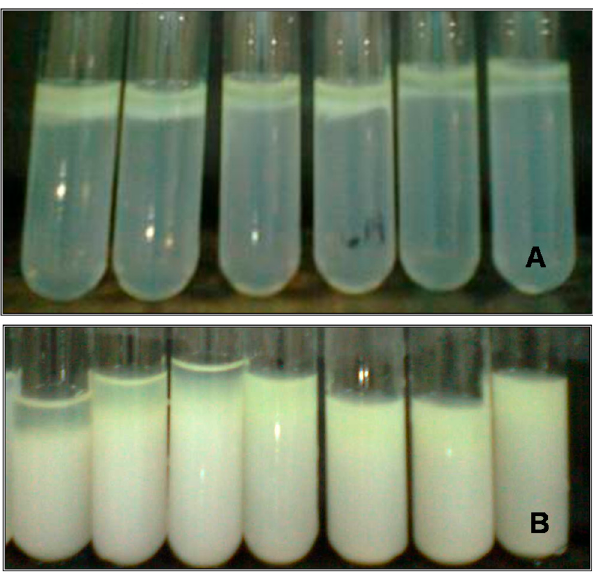
Figure 1. Separation of phases of NaCAS-XG systems due to thermodynamic incompatibility after 24 h ( A ) and 48 h ( B ) of incubation at 35 °C and controlled humidity.